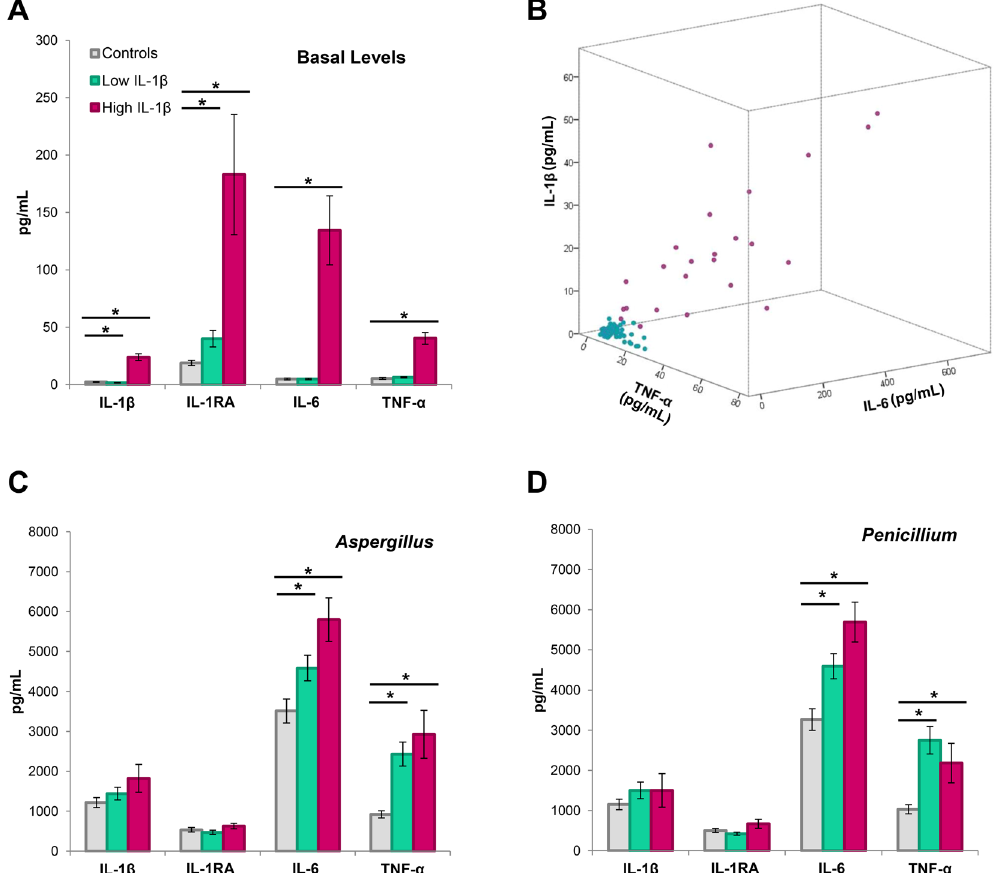
Figure 1. Cytokines at basal levels and after mold stimulation in PBMC. ( A ) All cases and controls at basal levels according to the levels of IL-1 β . ( B ) Scattered-plot of MD patients according to the levels IL-1 β , TNF- α and IL-6. Dots in green represent the patients with low levels of IL-1 β ( ≤ 5.9 pg/mL) whereas dots in purple are the patients with high levels of IL-1 β ( > 5.9 pg/mL) ( C ) All cases and controls after stimulation with Aspergillus . ( D ) All cases and controls after stimulation with Penicillium . * Significant p-values. IL-1RA, IL-1 receptor